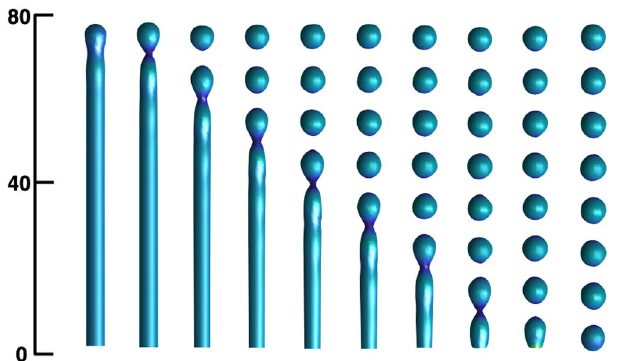
Figure 3. Snapshots of the evolution of the pearling instability in a long cylinder. Vesicles fission in sequence from the tip to the base. The parameters used were: R